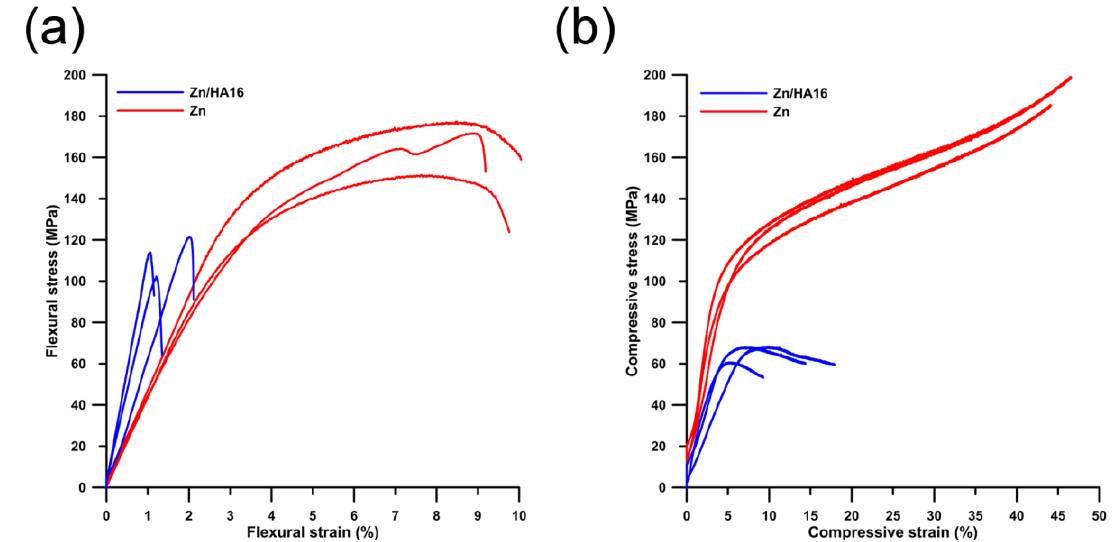
Figure 8. Engineering stress–strain ( a ) flexural and ( b ) compressive curves. Table 3. The overview of mechanical properties (average values) of selected biodegradable materials and the human